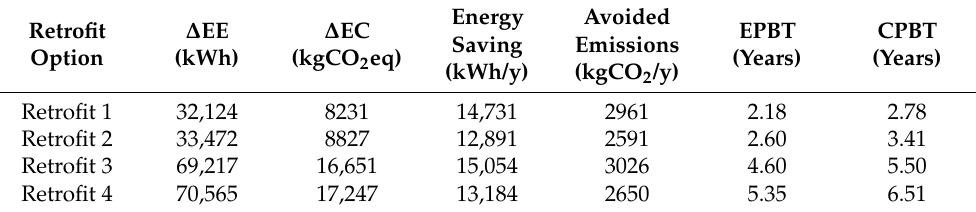
Table 2. Results related to energy and CO 2